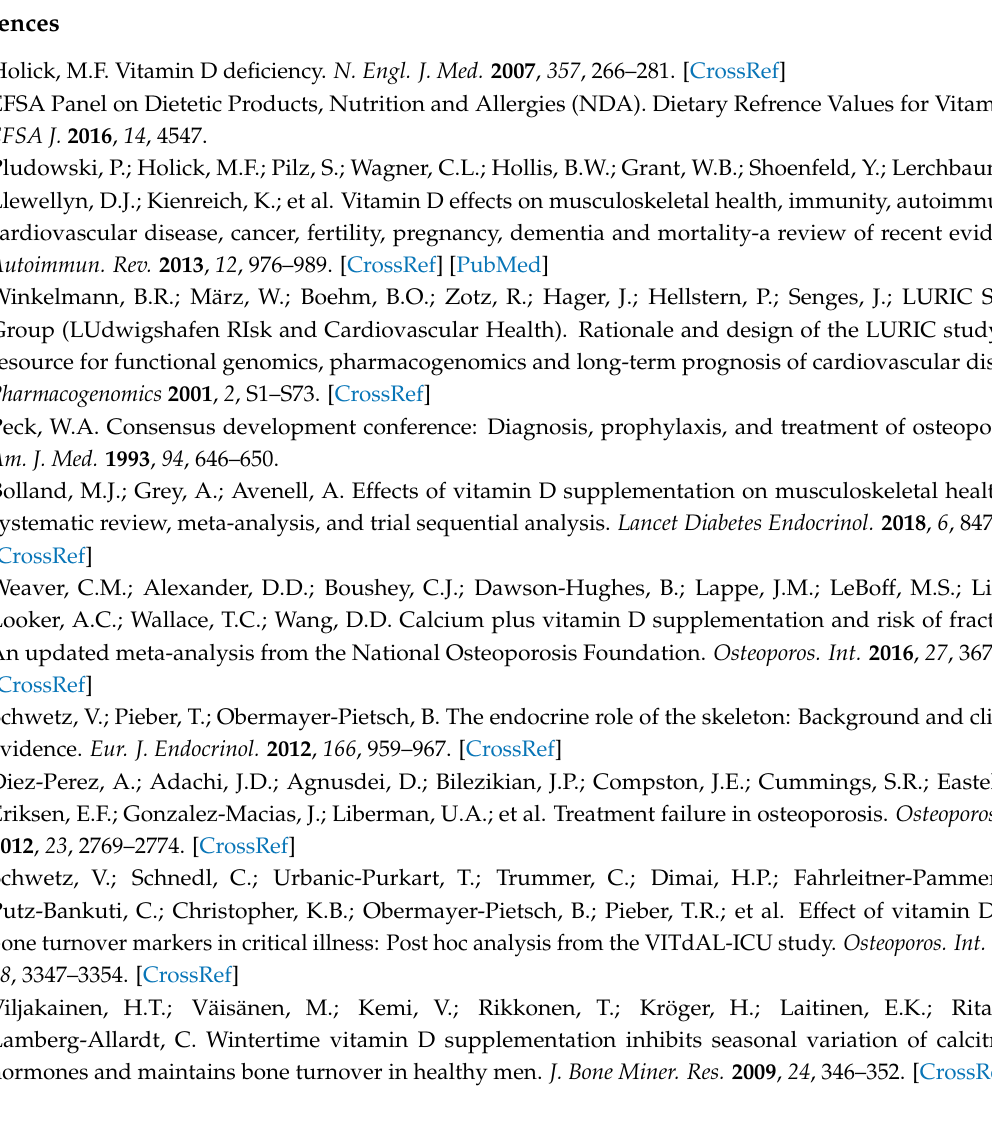
Figure S1: 25(OH)D levels at baseline and after 12 weeks in the placebo group. Paired student’s T-test was used for comparisons of 25(OH)D levels at baseline and